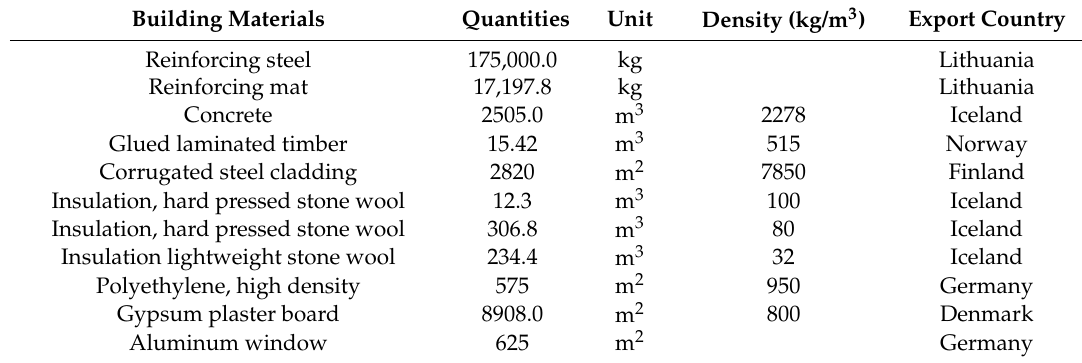
Table 1. Inventory data for building materials used in the school based on the tender documents.